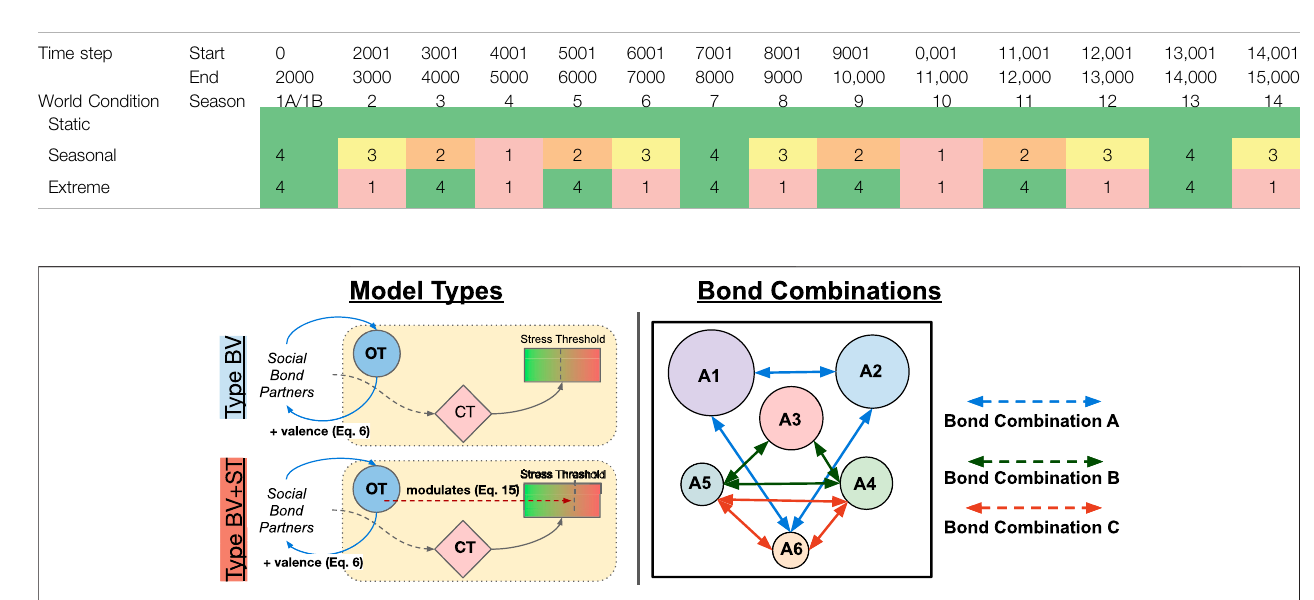
Frontiers in Robotics and AI |